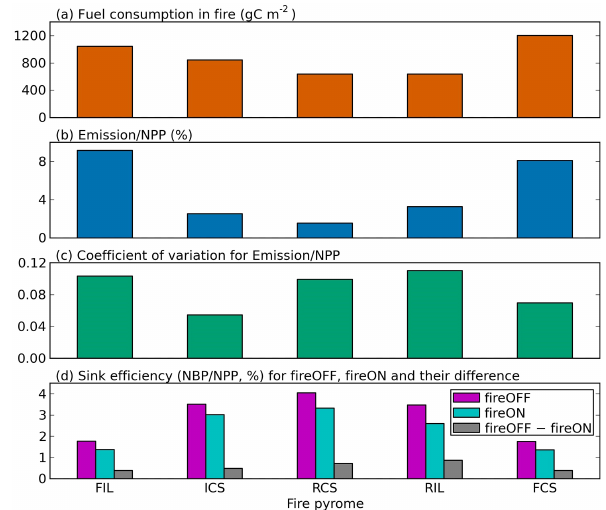
Figure 11. Characteristics of different fire pyromes (defined as by Archibald et al., 2013) in terms of the role of fires in the terres- trial carbon balance. (a) Fuel consumption in fire; (b) emissions as percentage of NPP; (c) coefficient of variation for the ratio of emissions against NPP; and (d) sink efficiencies (i.e. NBP/NPP) for fireOFF and fireON simulations and their difference. All vari- ables are shown for 1901–2012, except the fuel carbon consump- tion, which is averaged over 2003–2012. The five fire pyromes are FIL, frequent–intense–large; ICS, intermediate–cool–small; RCS, rare–cool–small; RIL, rare–intense–large; and FCS, frequent–cool– small. Refer to Fig. S2 for their spatial